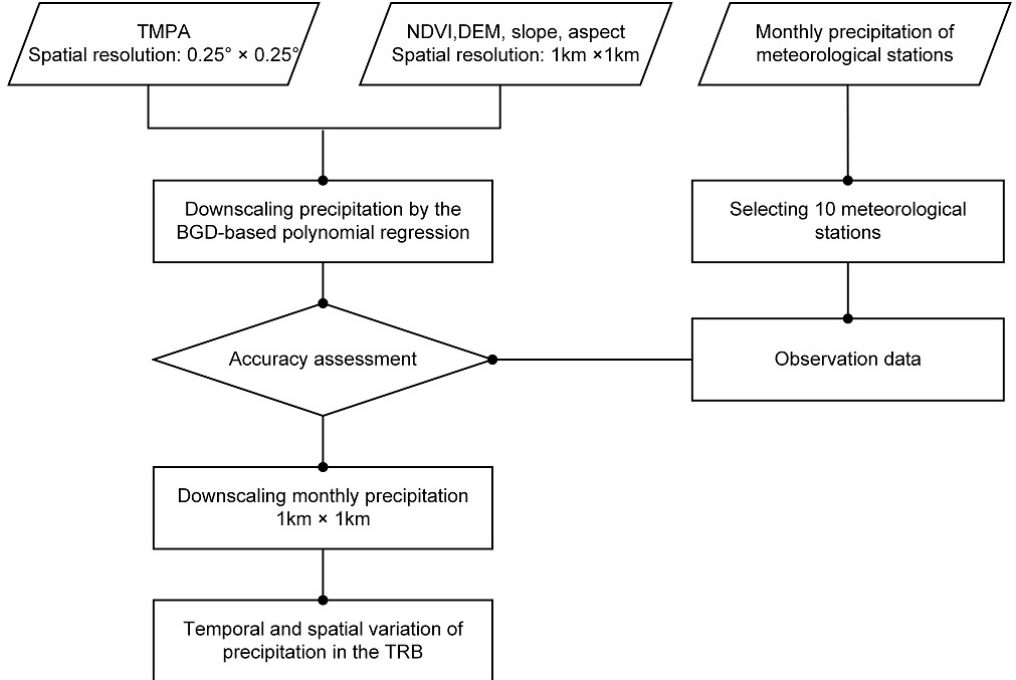
Figure 2. The framework of the integrated model for downscaling precipitation.